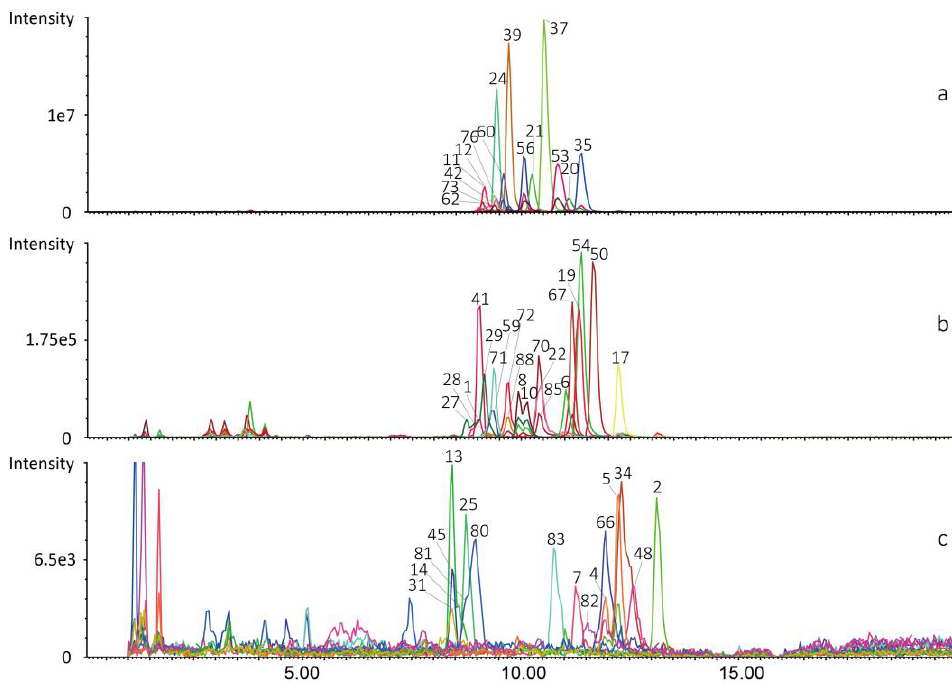
Figure 2. Integration of individual peak in extracted ion chromatograms (EICs) of the 58 CLs in liver tissue by UPLC-QTOF-MS/MS. ( a ) CLs with peak intensity > 1.93 × 10 5 and <1.2 × 10 7 cps. ( b ) CLs liver tissue by UPLC-QTOF-MS/MS. ( a ) CLs with peak intensity >1.93 × 10 5 and <1.2 × 10 7 cps. with peak intensity > 1.54 × 10 4 and <2 × 10 5 cps. ( c ) CLs with peak intensity > 1.46 × 10 3 and <8.3 × ( b ) CLs with peak intensity >1.54 × 10 4 and <2 × 10 5 cps. ( c ) CLs with peak intensity >1.46 × 10 10 3 cps. Peak numbers of compounds are consistent with those in Table S1.